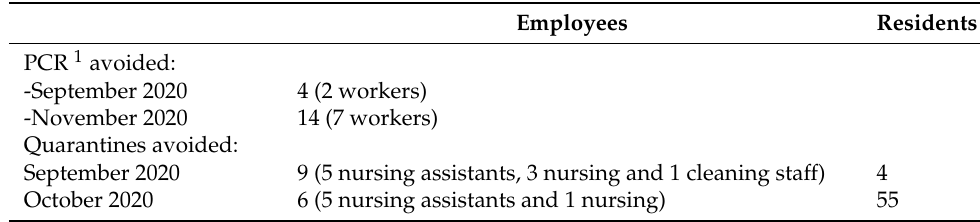
Table 2. Avoided resources in the second wave.